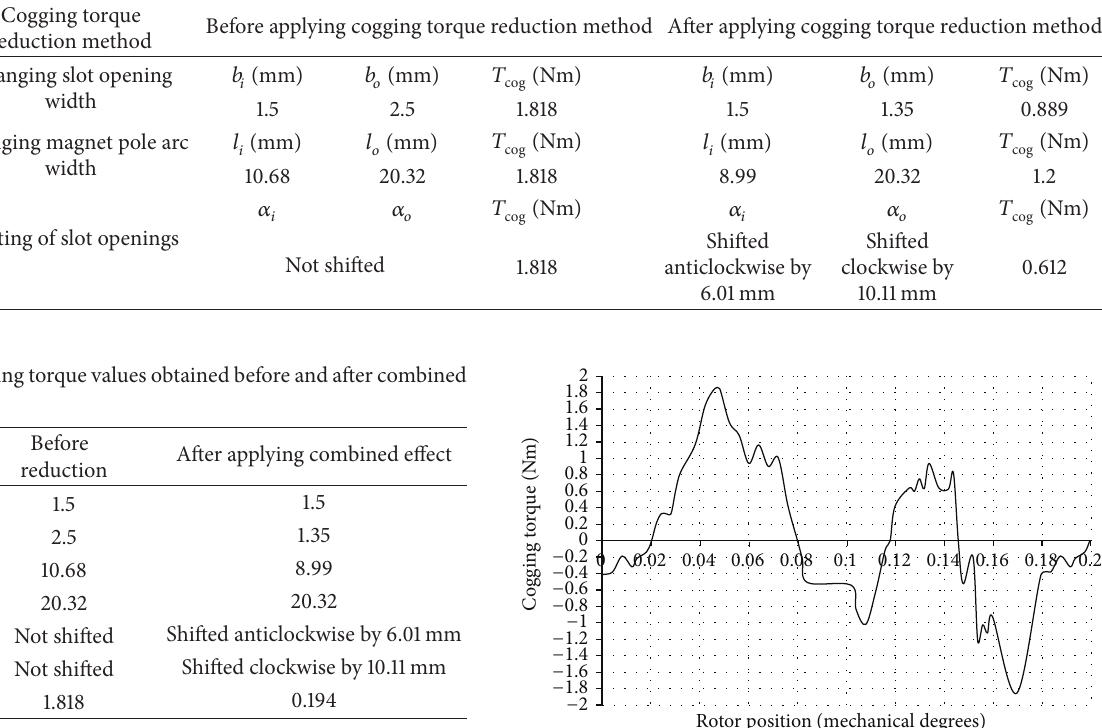
of the slot opening of the inner periphery ( 𝜃 𝑖 ) and outer slots on the outer periphery of the stator. Due to this, the